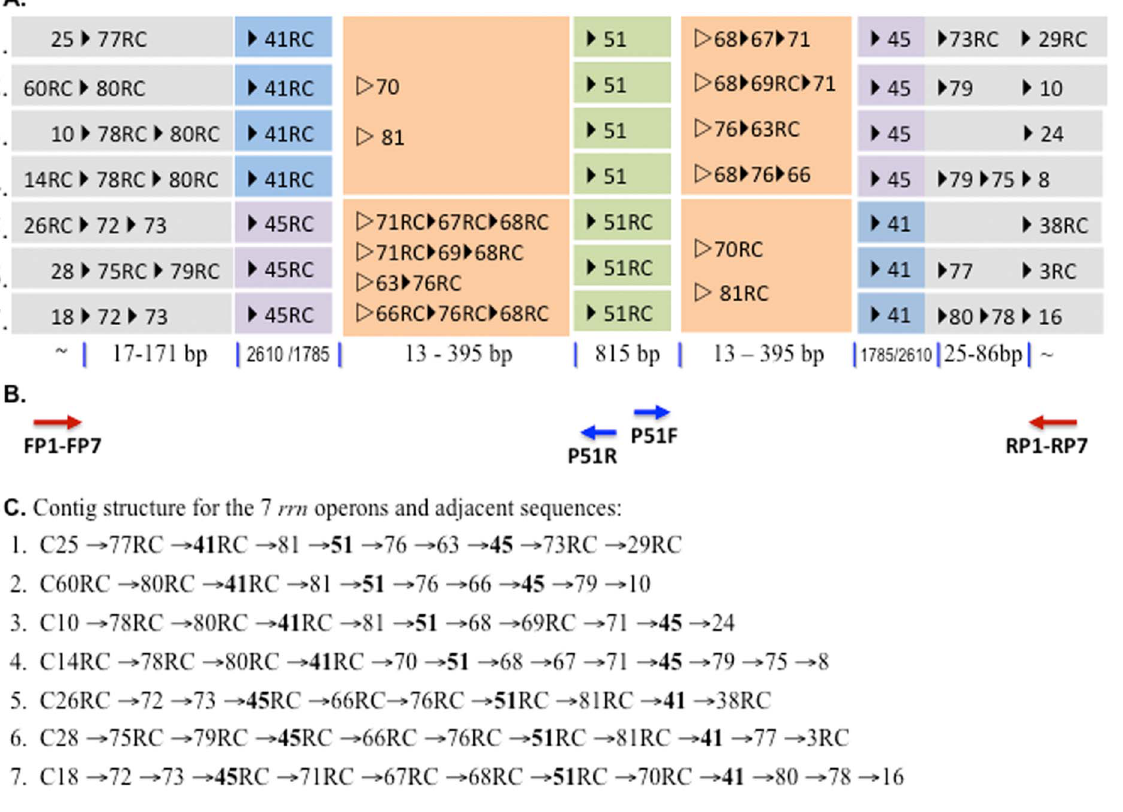
Figure 6. Resolved sequence structures for the 7 rrn operons in MRSN 2154. PCR and Sanger sequencing were used to determine the variable regions in rrn operons. RC, reversed and complementary. ( A ) Illustration of contig assembly for the 7 rrn operons and adjacent sequences. Variable regions between rRNA sequences (contigs 41, 45 and 51) were shown in orange boxes and indicated as orientation-undecided by the empty arrow . The sizes for the ribosomal and intergene regions are shown. ( B ) Schematic representation of regions to be amplified and the Sanger sequencing directions. Seven rrn regions were amplified by PCR using 7 pairs of primers, FP1-FP7 and RP1-RP7 which are corresponding to specific sequences flanking the rrn regions. Sanger sequencing outward from the conserved rRNA sequence (contig 51) in both directions with primers P51R and P51F was used to determine the intergene spacer regions. ( C ) The results for rrn operon sequence structures resolved by PCR amplification and Sanger sequencing.